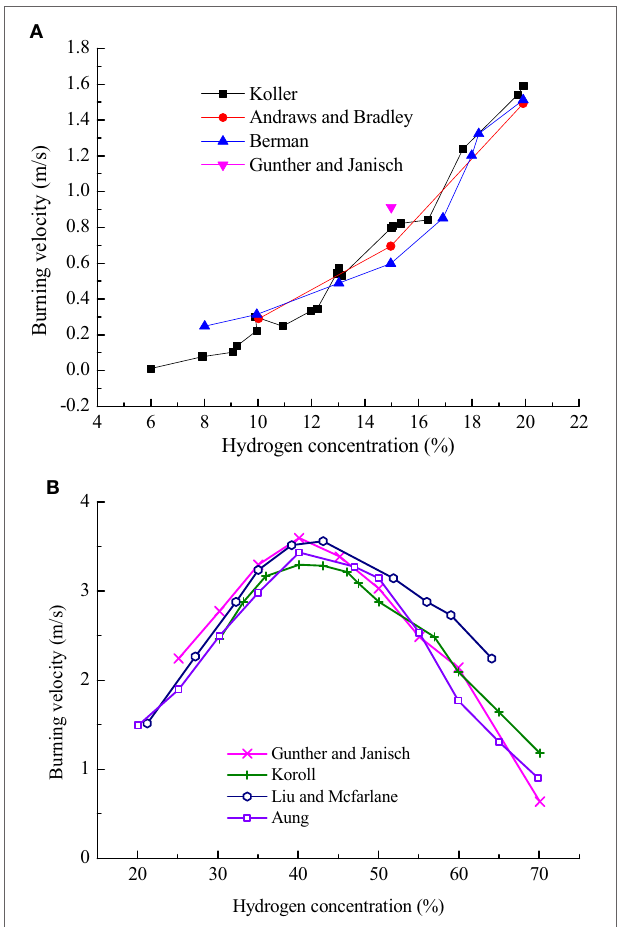
FIGURE 1 | The laminar burning velocities for hydrogen–air mixtures plotted as a function of the hydrogen concentration: (A) C hydrogen < 20%; (B) C hydrogen > 20%.